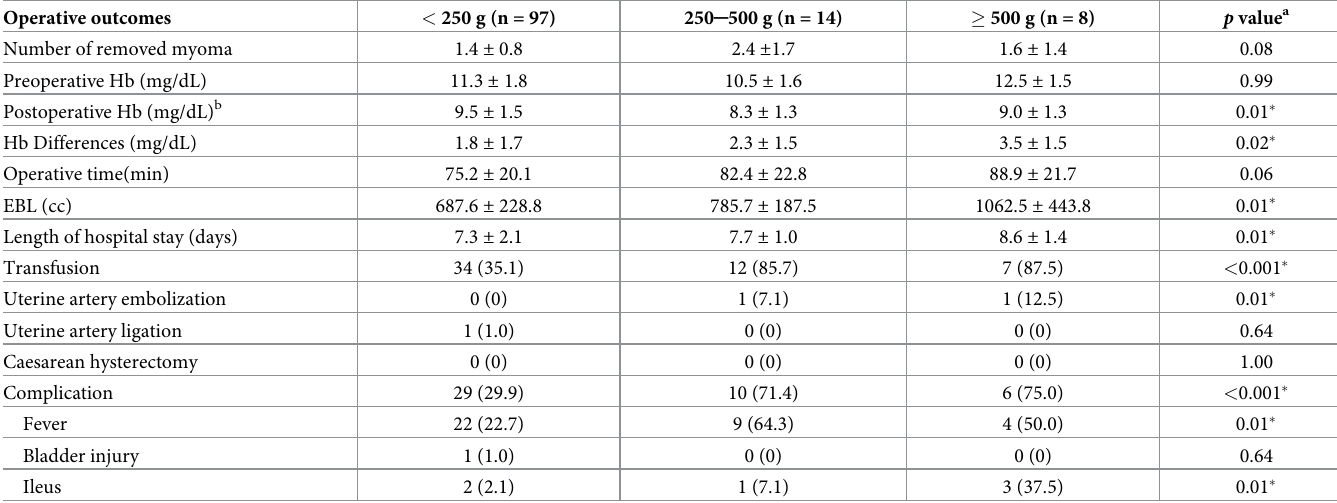
Table 6. Operative outcomes according to the myoma weight in CM group (n =